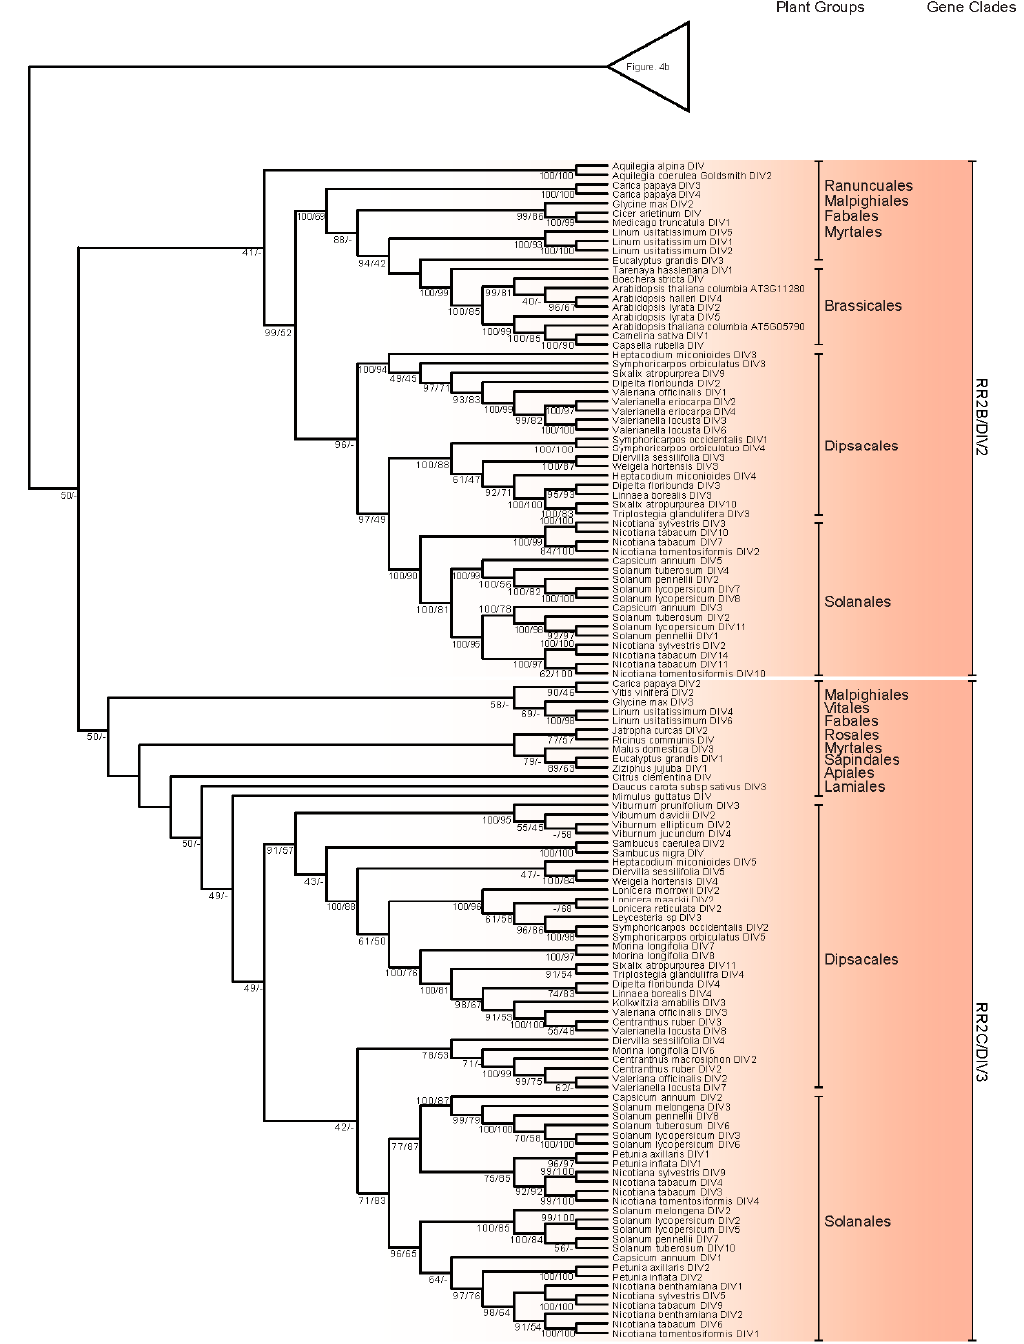
Figure 4. Phylogeny of R-R- type genes based on Bayesian and ML inferences. Two hundred and ninety-eight CDSs of R-R- type genes from both monocots and dicots were analyzed. They formed two major clades, RR1 and RR2/DIV, each of which contained sequences from monocots and dicots. The RR1 clade was further divided into three groups, RR1A, RR1B, and RR1C. For the three RR2/DIV clades identified by Howarth and Donoghue [22] only the DIV2 and DIV3 are monophyletic. The Arabidopsis sequences include AT2G38090, AT5G01200, and AT5G58900 identified as DIV1, which is not a clade in this phylogeny. Bayesian posterior probabilities and bootstrap frequencies ≥ 40% depicted close to the branches, respectively.